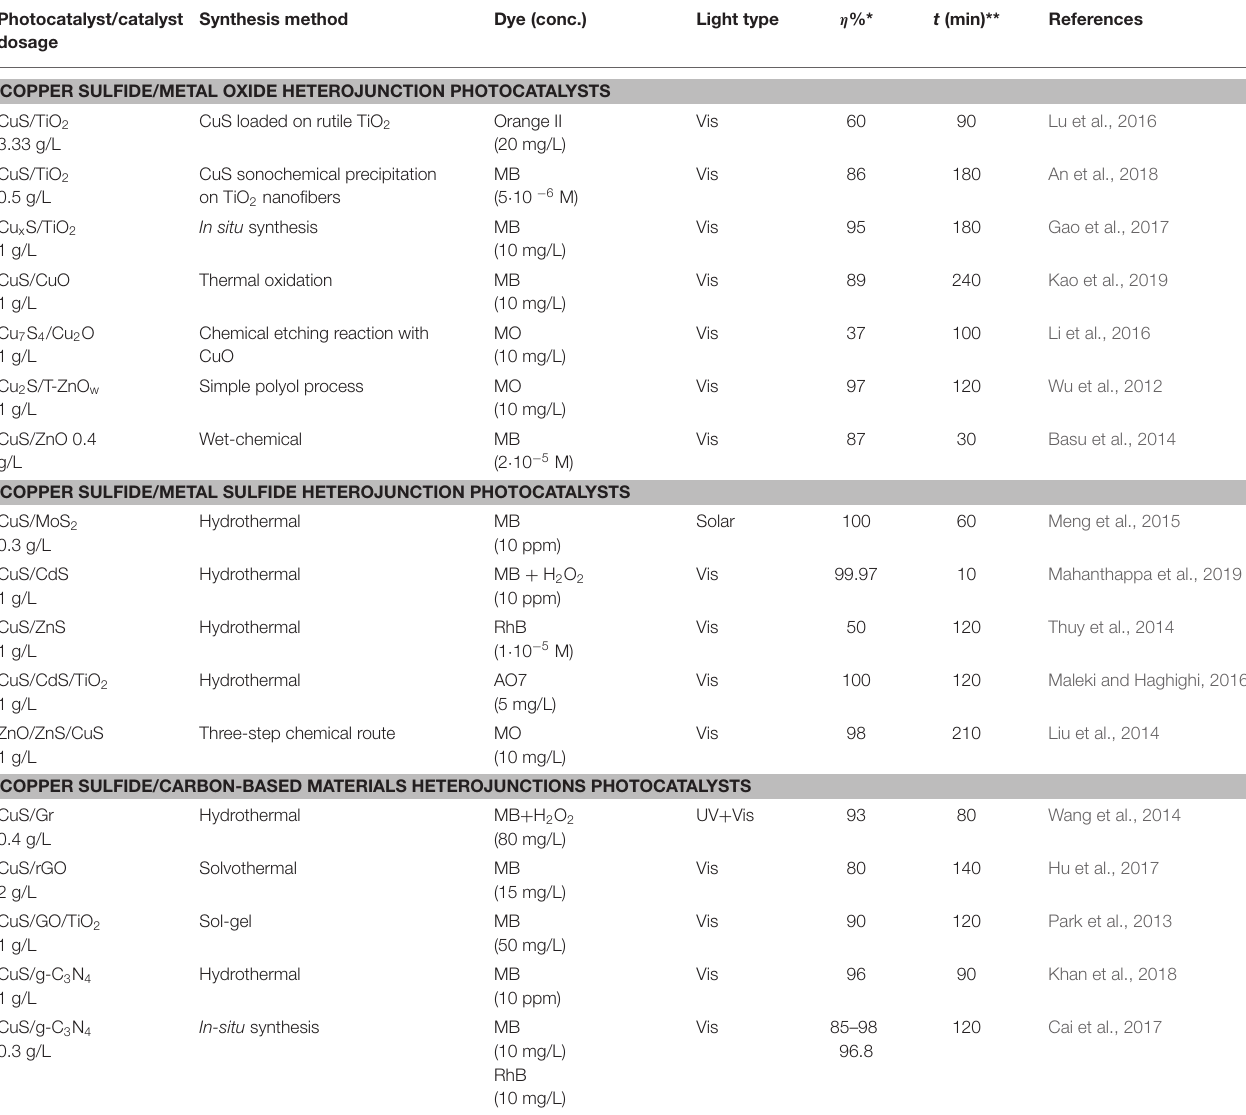
TABLE 1 | Representative studies on dyes photocatalytic degradation using various heterojunctions based on nanostructured copper sulfides as photocatalysts. Photocatalyst/catalyst